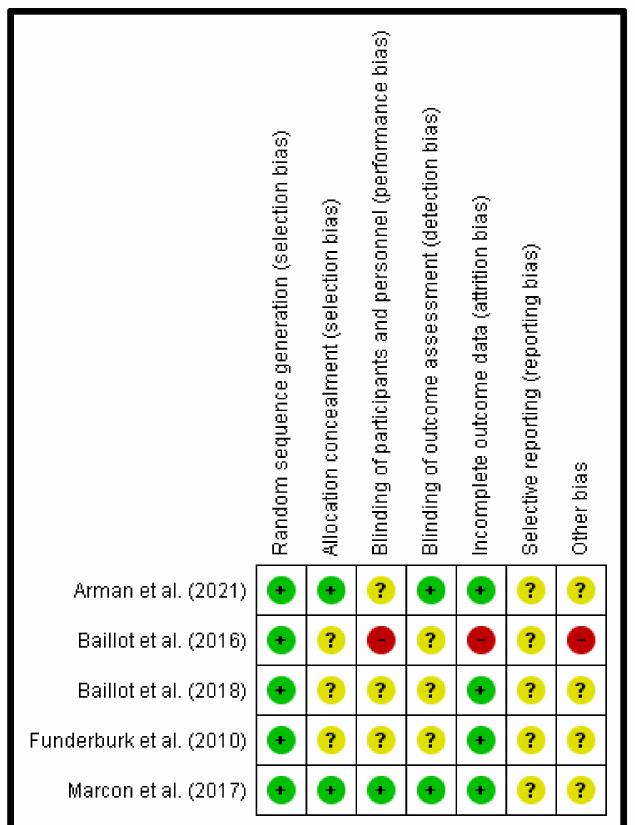
Figure 3. Risk of bias evaluation per study [11,15–18]. Red (-) = high risk of bias; Yellow (?) = un- known risk of bias; Green (+) = low risk of bias.